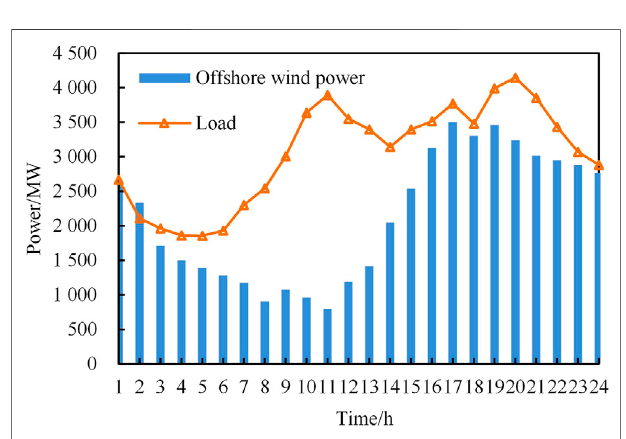
FIGURE 4 | Prediction curves of offshore wind power and load.